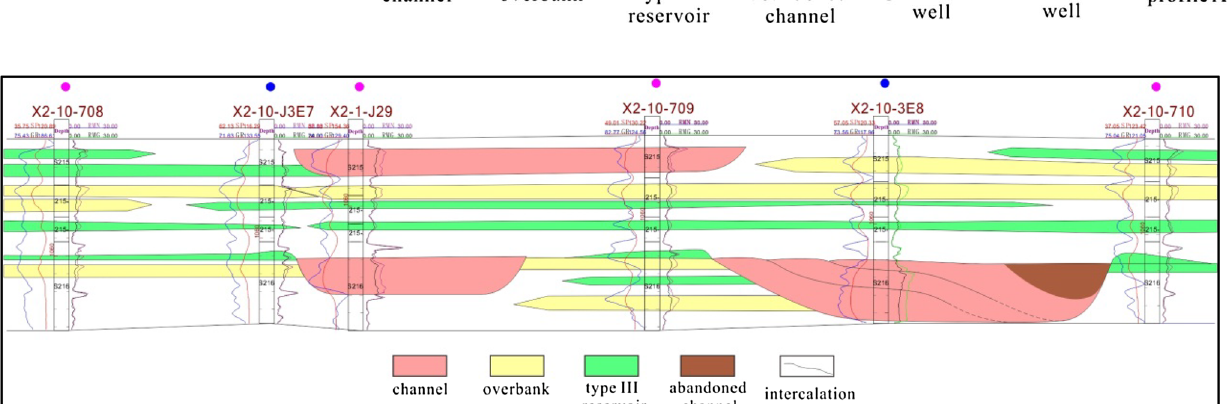
Fig. 6 Reservoir architecture of the S2 layer set of profile A in the study